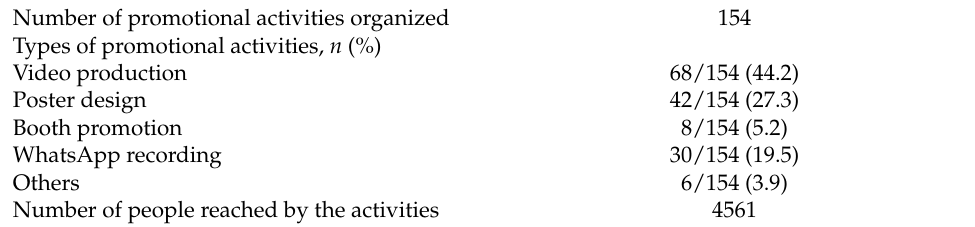
Table 5. Promotional activities organized by anti-drug